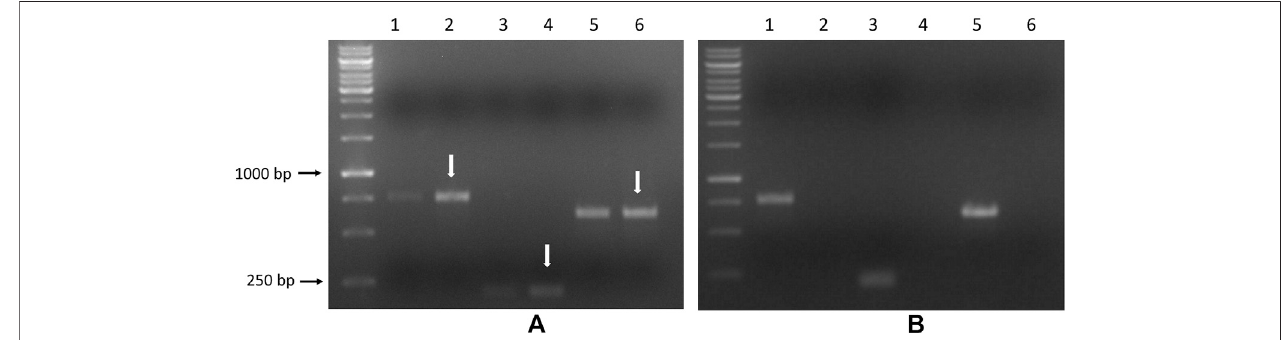
FIGURE 11 | U87 (A) and 3T3 cells (B) were treated with 20 nM APTSAP for 96 h, total RNA was extracted from cell pellets. PCR was performed on the corresponding cDNA using the three couples of primers, as described in the Materials and Methods section. pET11d plasmid carrying the wild type saporin gene (pET11d-SAP) was used as a positive control. Ampli fi ed products are indicated by arrows, and the expected dimensions are: FW1/RV1:765 bp, FW2/RV2: 204 bp, FW3/RV3: 621bp. Lanes 1-3-5: pET11d-SAP; lanes 2-4-6: